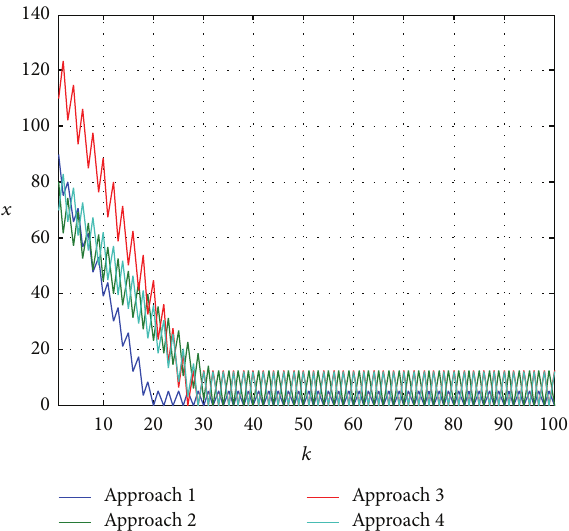
Figure 2: Evolution of queues within dissipative closed loop system.